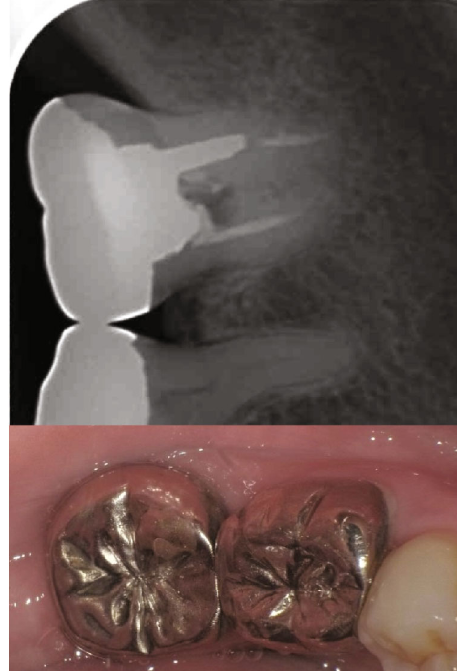
Figure 10: Twenty-nine years after the procedure, this patient maintains good oral hygiene and gingival health.